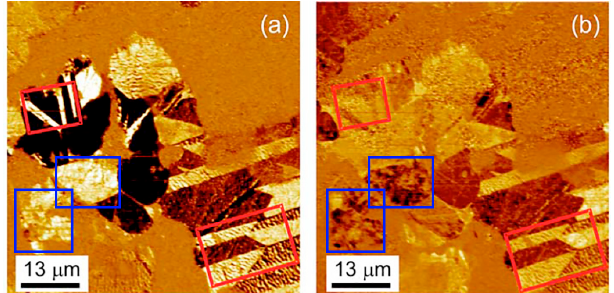
Figure 6. ( a ) Out-of-plane and ( b ) in-plane PFM images of lamellar (red squares) and blotch (blue squares) domain structure in BiFeO 3 . Adapted from [89], with permission from © 2007 AIP Publishing LLC.